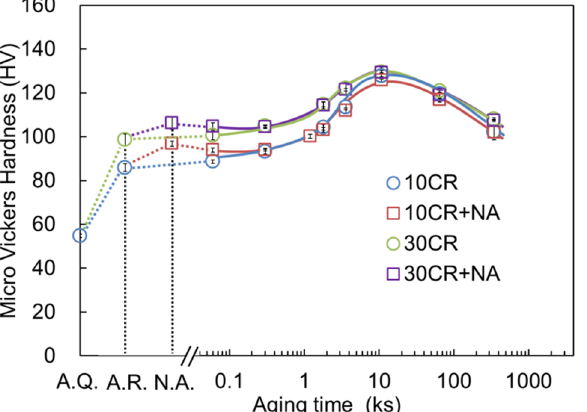
Figure 4. Hardness change of 10CR, 10CR + NA, 30CR and 30CR+NA samples during artificial aging at 170 °C.